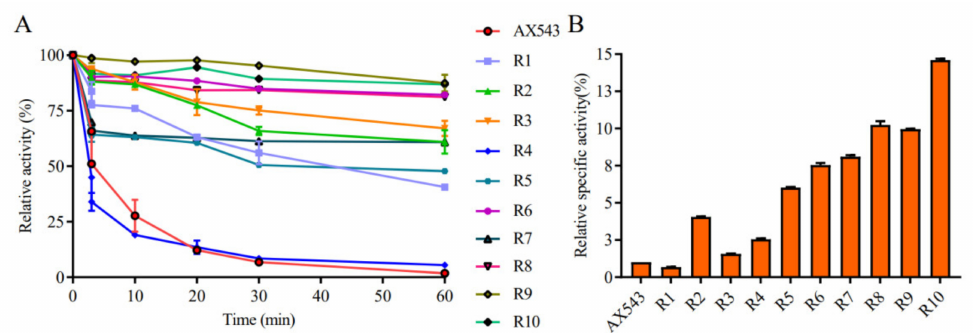
Figure 10. The thermostability ( A ) and specific activities ( B ) of purified xylosidase AX543 and its